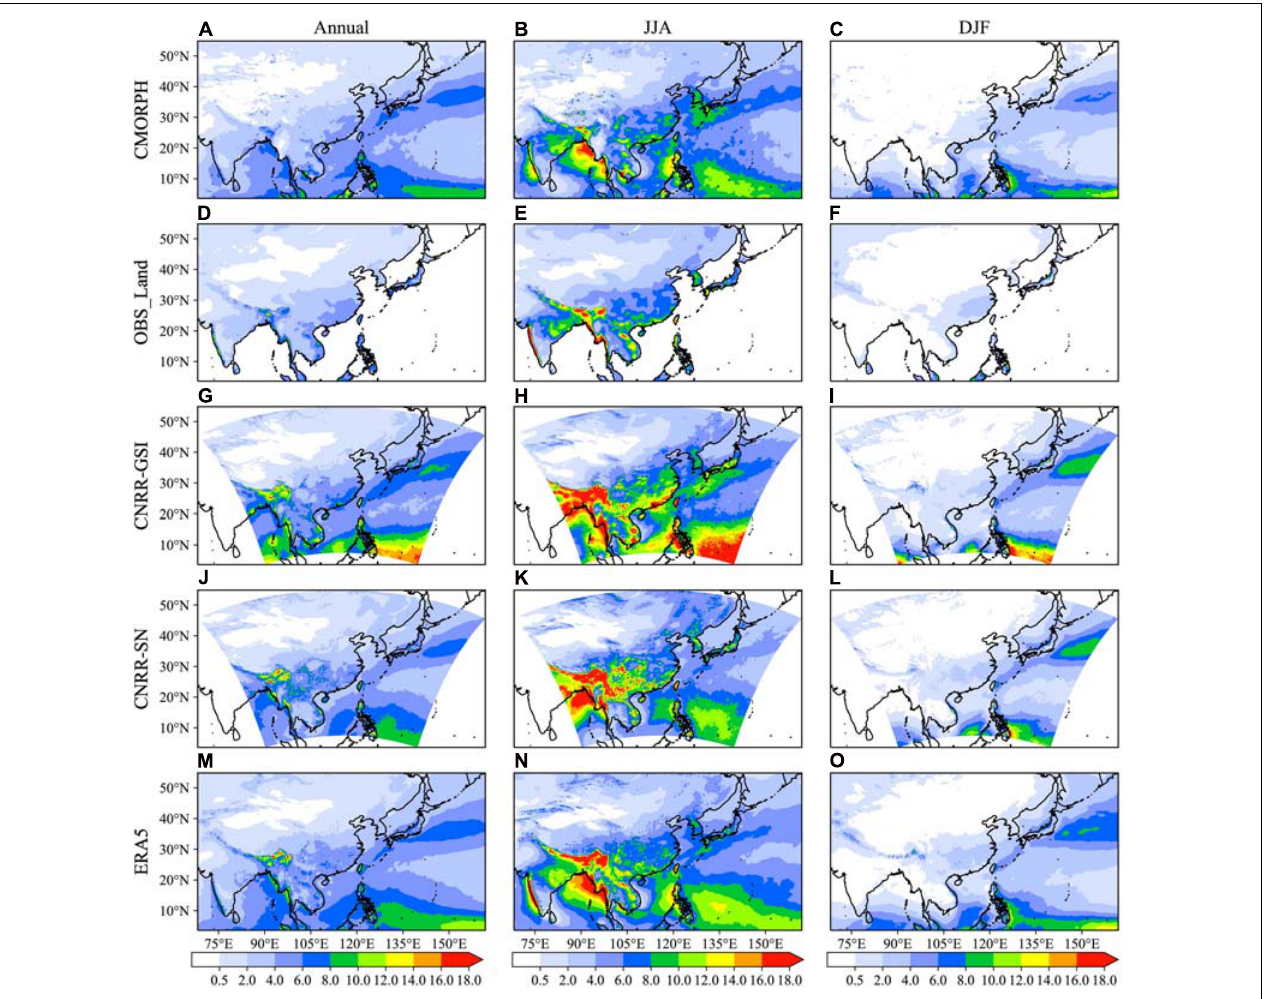
FIGURE 2 | Distribution of the annual, summer (JJA) and winter (DJF) precipitation from observations (A–F) , CNRRs (G–L) and ERA5 (M–O) (1998–2009), unit: